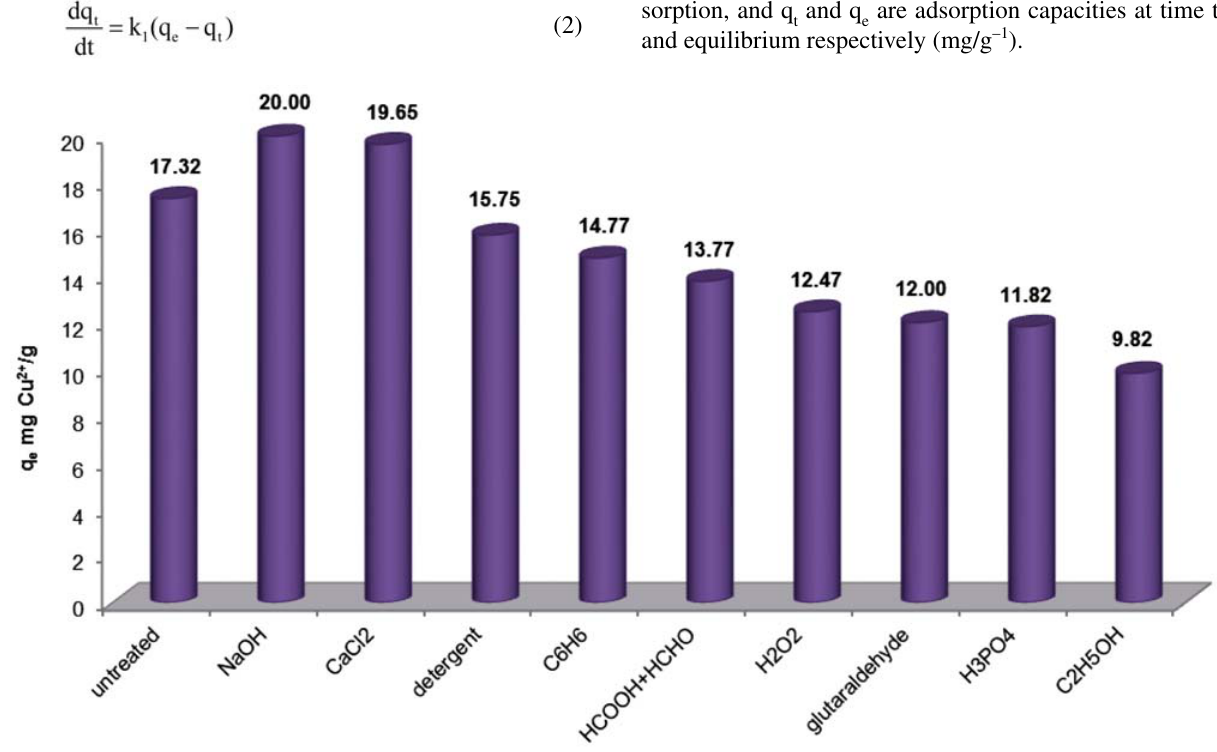
= 40 mg/L, 0.1 g/100 ml (dry mass per volume), 23 i